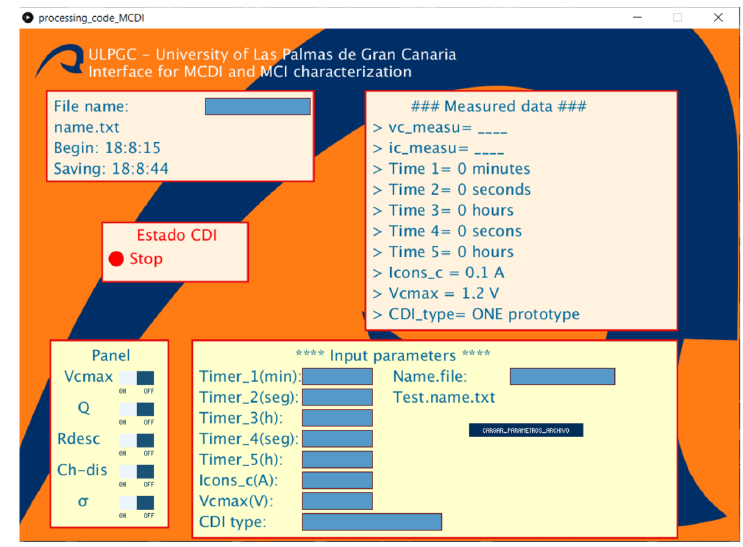
Figure 3. − Processing PC control interface and data